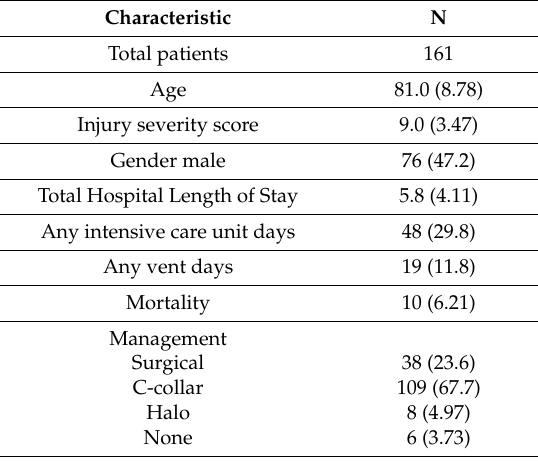
Table 1. Overall